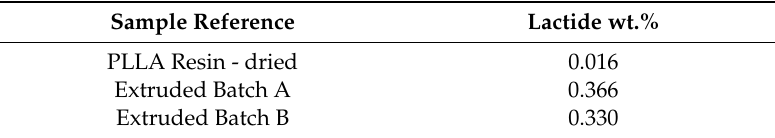
Table 3. GC-FID results presenting the lactide weight percentage of the PLLA resin (dried) and extrusion Batches A and B.